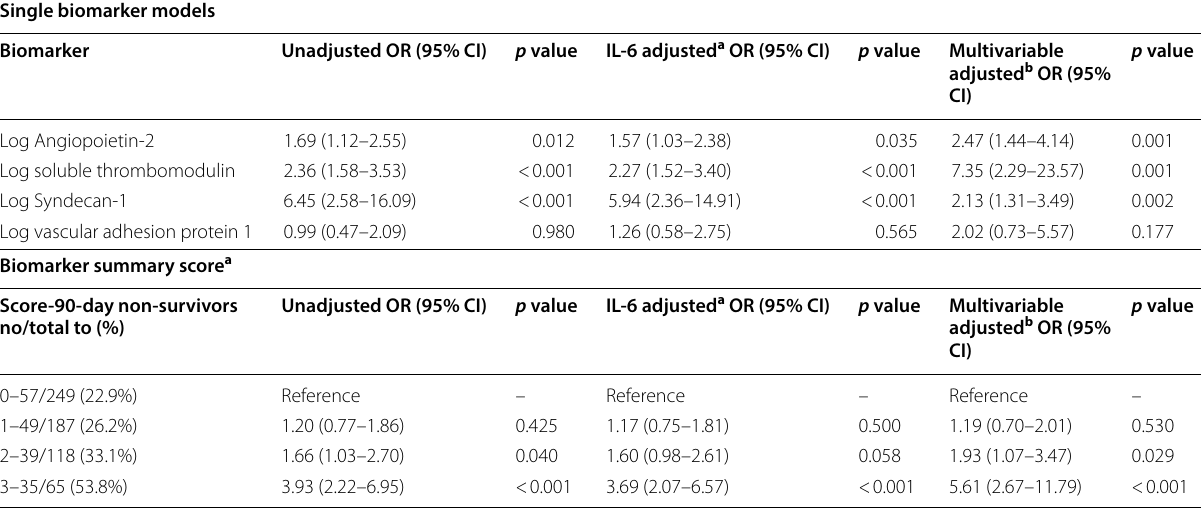
Hosmer–Lemeshow test non-significant in all analyses IL-6 interleukin-6 a Adjusted for log-transformed interleukin-6 value at ICU admission b Adjusted for age, sex, body mass index, pre-existing arteriosclerosis, chronic heart failure, chronic kidney disease, diabetes mellitus, chronic corticosteroid use, operative admission, skin or soft tissue infection, central nervous system infection, other infection source, need for vasoactive medication within first 24 h, Simplified Acute Physiology Score (SAPS) II without points for age and renal components, first lactate in ICU, acute kidney injury within first 5 days in the ICU, fluid accumulation percentage of baseline weight within first 5 days in ICU, mechanical ventilation during ICU stay, and log-transformed interleukin-6 value at ICU admission. Total number of patients in the model was 619 c Including Angiopoietin-2, soluble thrombomodulin and Syndecan-1, each value in the highest tertile for each biomarker yielding a subscore of 1